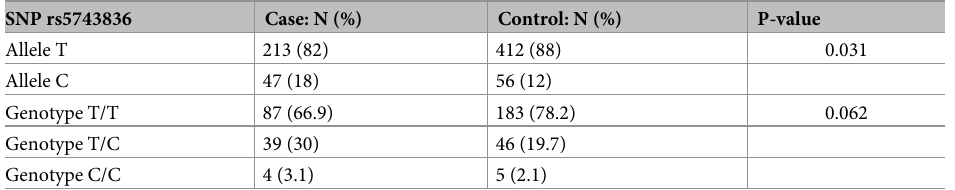
Table 3. Allele and genotype frequency in cases and controls.